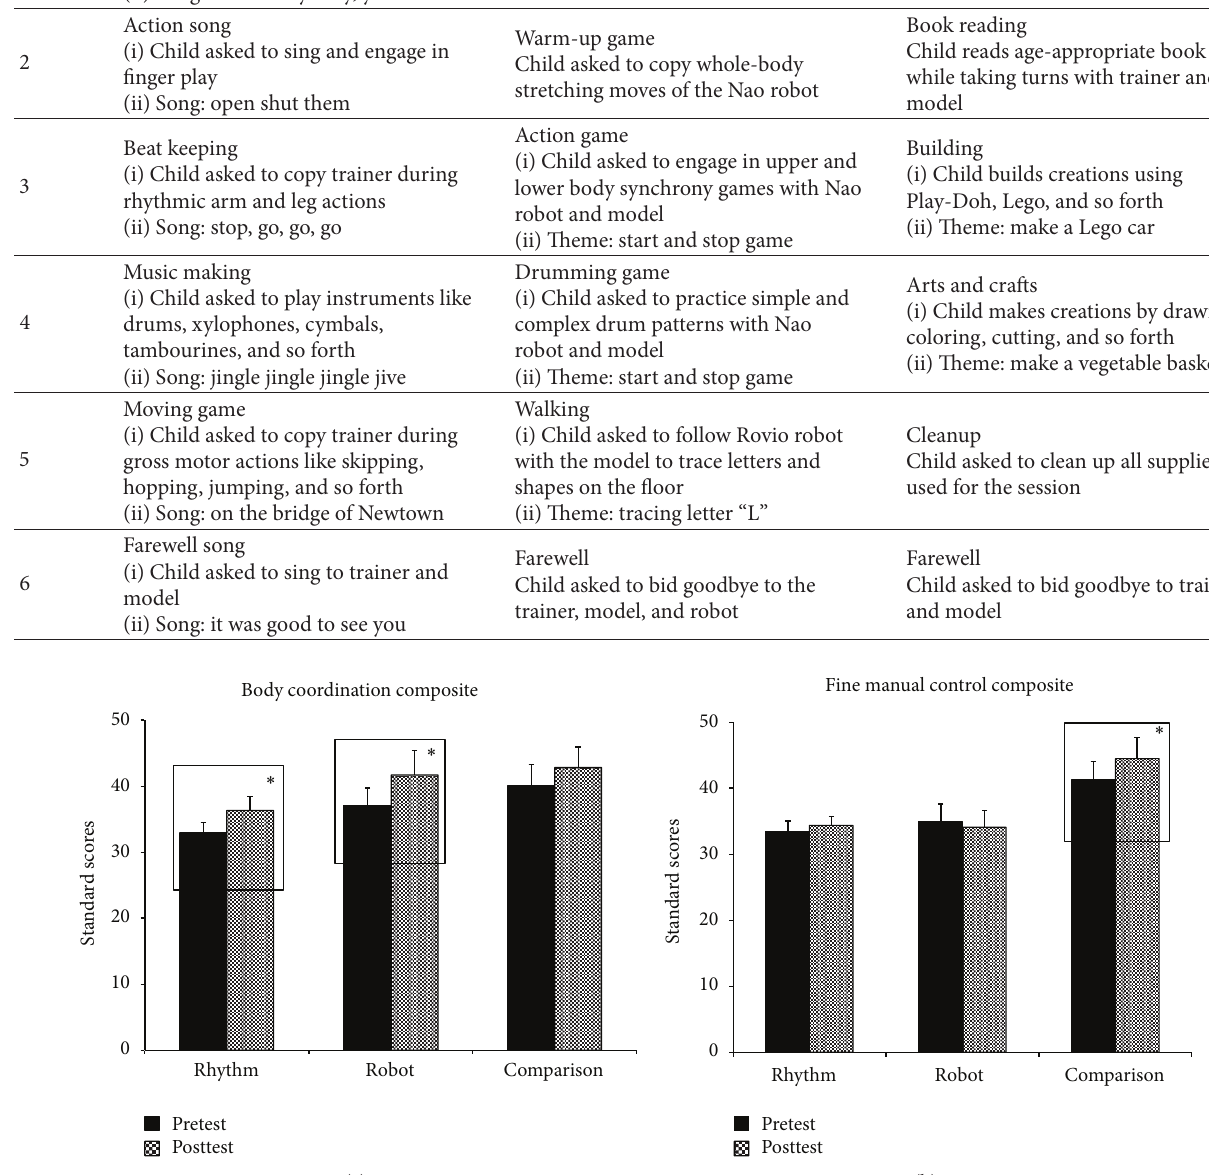
improved their scores on the body coordination